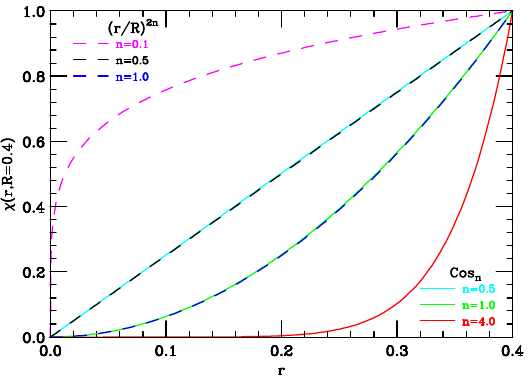
Figure 1 . The different shapes of the isolation functions χ ( r ; R ) for selected values of the power n and with R = 0 . 4. The functions χ ( r ; R ) in eqs. (2.3) and (2.4) are labelled as ( r/R ) 2 n (dashed lines) and Cos n (solid lines),